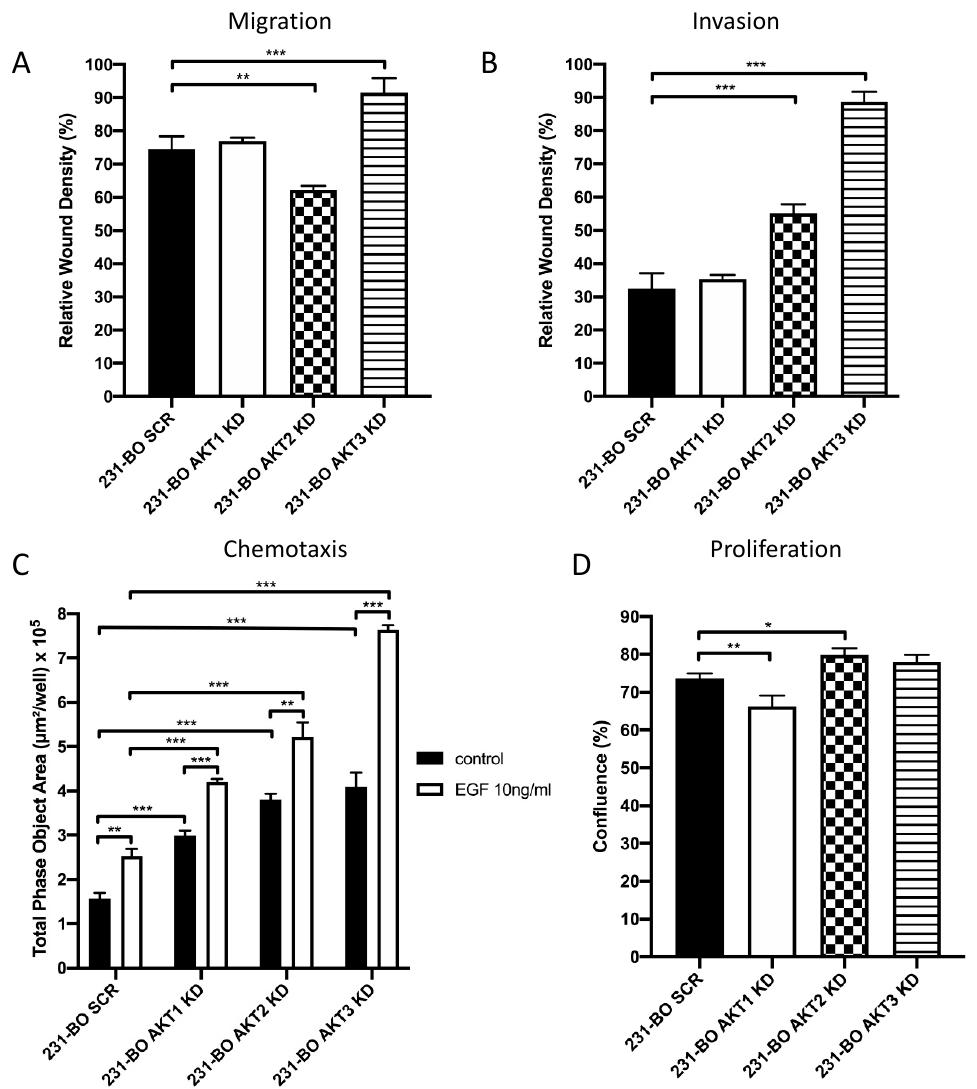
Figure 5. Knockdown of AKT3 in 231-BO cells promotes migration, invasion, and chemotaxis towards EGF but has no effect on proliferation: ( A ) Migration of 231-BO cells with AKT isoform knockdowns was tested using a wound healing scratch assay. Relative wound density was analyzed from triplicates by the IncuCyte live cell imaging system. Bars indi- cate mean with SD; ** = p < 0.01, *** = p < 0.001. ( B ) 231-BO AKT isoform knockdown cells were seeded in a 96 well plate in triplicate for invasion assay. Matrigel was added as an ECM after scratch wounds were created. The IncuCyte live cell imaging system was used to determine relative wound density. Bars indicate mean with SD; *** = p < 0.001. ( C ) Chemotaxis of 231-BO cells with AKT isoform knockdowns was tested with a Boyden chamber assay using the IncuCyte live cell imaging system. Cells were seeded in the upper chamber and EGF in a concentration of 10ng/mL was added to the lower chamber. Boyden chambers without an EGF gradient served as control. The area of the lower chamber occupied with transmigrated cells through pores was determined. Bars indicate mean with SD; ** = p < 0.01, *** = p < 0.001. ( D ) 231-BO cells harboring AKT isoform knockdowns were seeded in a 96-well plate and confluence was monitored with the IncuCyte live cell imaging system. Bars indicate mean with SD; * = p < 0.05, ** = p < 0.01.